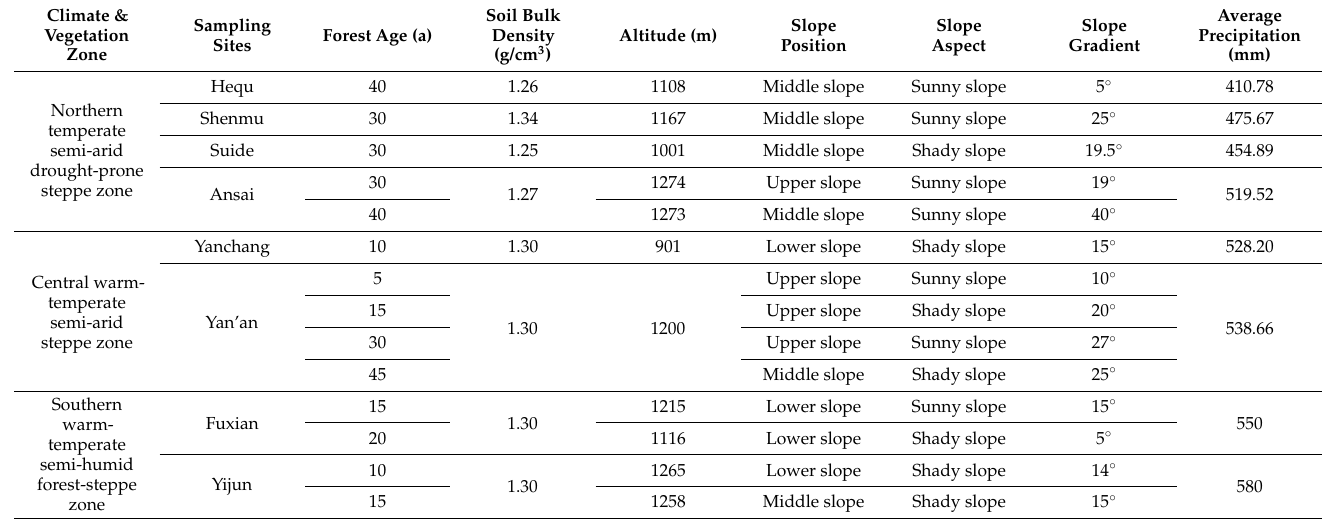
Table 1. Background information of soil-moisture-sampling sites under R. pseudoacacia forests on the Loess Plateau of